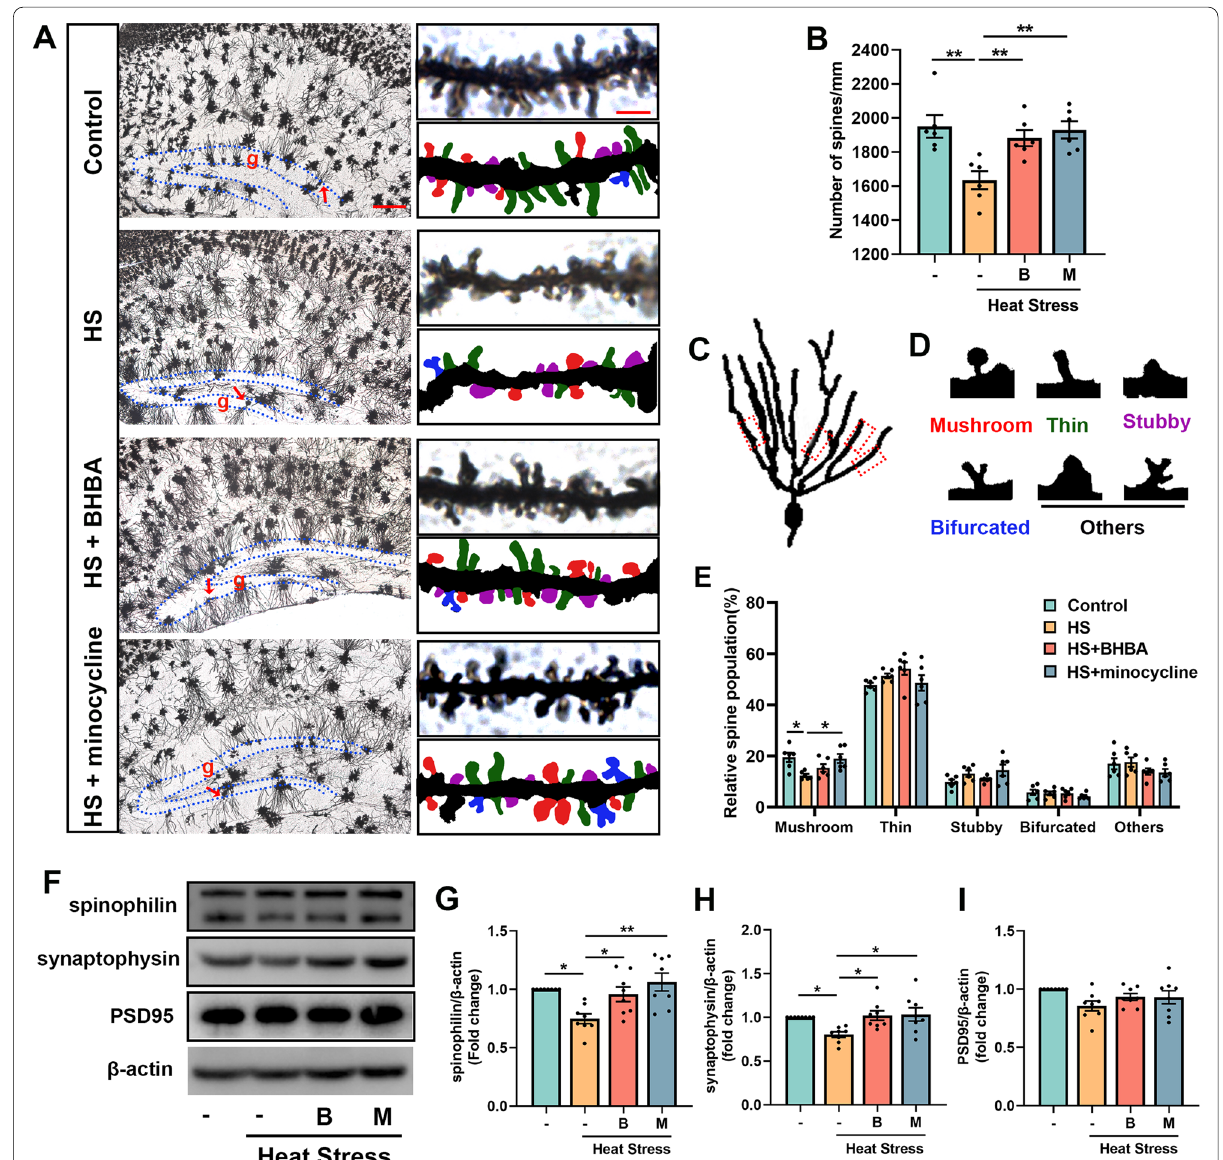
Fig. 2 BHBA increases the density of dendritic spines and the expressions of synapse-associated proteins in the heat stress-treated mouse hippocampus. A Representative images of coronal sections subjected to Golgi staining from the hippocampus. Red arrows indicate granule cells in the hippocampal GCL (g, blue dashed box) of dentate gyrus. Dendritic reconstructions indicate the different types of spines according to their shape: mushroom (red), thin (green), stubby (purple), bifurcated (blue), and others (black). B Quantitative analysis of spine density of hippocampal granule cells. The spine density of granule cells was significantly lower in the heat stress-treated mice compared with that in the controls. BHBA or minocycline administration elevated spine density. C Representative morphology of granule cell of dentate gyrus with Golgi staining and the framed dendrite section for the analysis of spine density and morphology. D Representative photomicrographs of each type of spine. E Quantitative analysis of the classified spines in the hippocampal dentate gyrus. The proportion of mushroom spines decreased in the heat stress exposure group compared to that in the control group. And the proportion of other types of spines did not show a statistical difference among the four groups. F Immunoblotting images of spinophilin, synaptophysin, PSD95, and β-actin protein expressions in the hippocampus. G‑I Quantitative densitometric analysis of spinophilin ( G ), synaptophysin ( H ), and PSD95 ( I ) in different groups. Mice treated with heat stress for 14 days showed significant decreases in the expressions of spinophilin and synaptophysin. After treatment with BHBA or minocycline, the expressions of spinophilin and synaptophysin showed remarkable increases in the heat stress-treated mice. Scale bar 10 μm (left) or 2.5 μm (right) in A . Data were normalized = to β-actin: expression of the target protein intensity of target protein band/intensity of β-actin. The results are presented as the ratio of the = experimental group to the control group with the value taken as 1. All data analyses were performed using one-way ANOVA with Tukey’s post-test. Data are represented as mean SEM. B, E n 6 from 3 mice. G‑I n 8. * p < 0.05, ** p < 0.01. B, BHBA; g, GCL; HS, heat stress; M, minocycline; PSD95, ± = = postsynaptic density protein